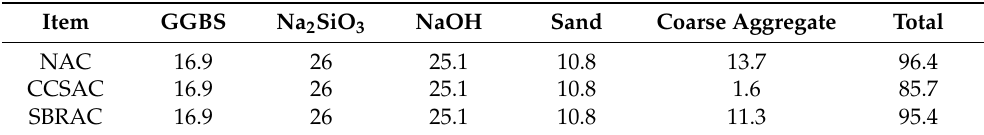
Table 9. Cost of one cubic meter of concrete (USD/m 3